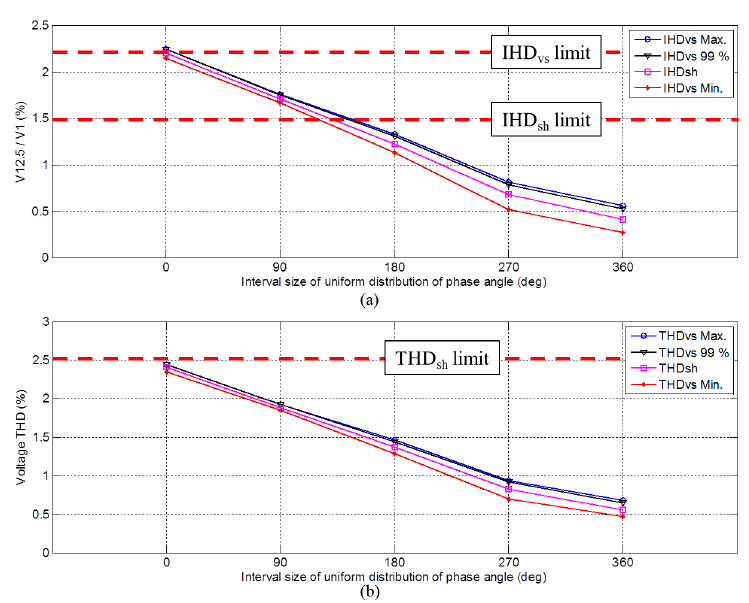
Figure 13. The 12.5th order very short time IHD and voltage THD in the variation of the interval size of the phase angle: ( a ) 12.5th order; and ( b ) voltage